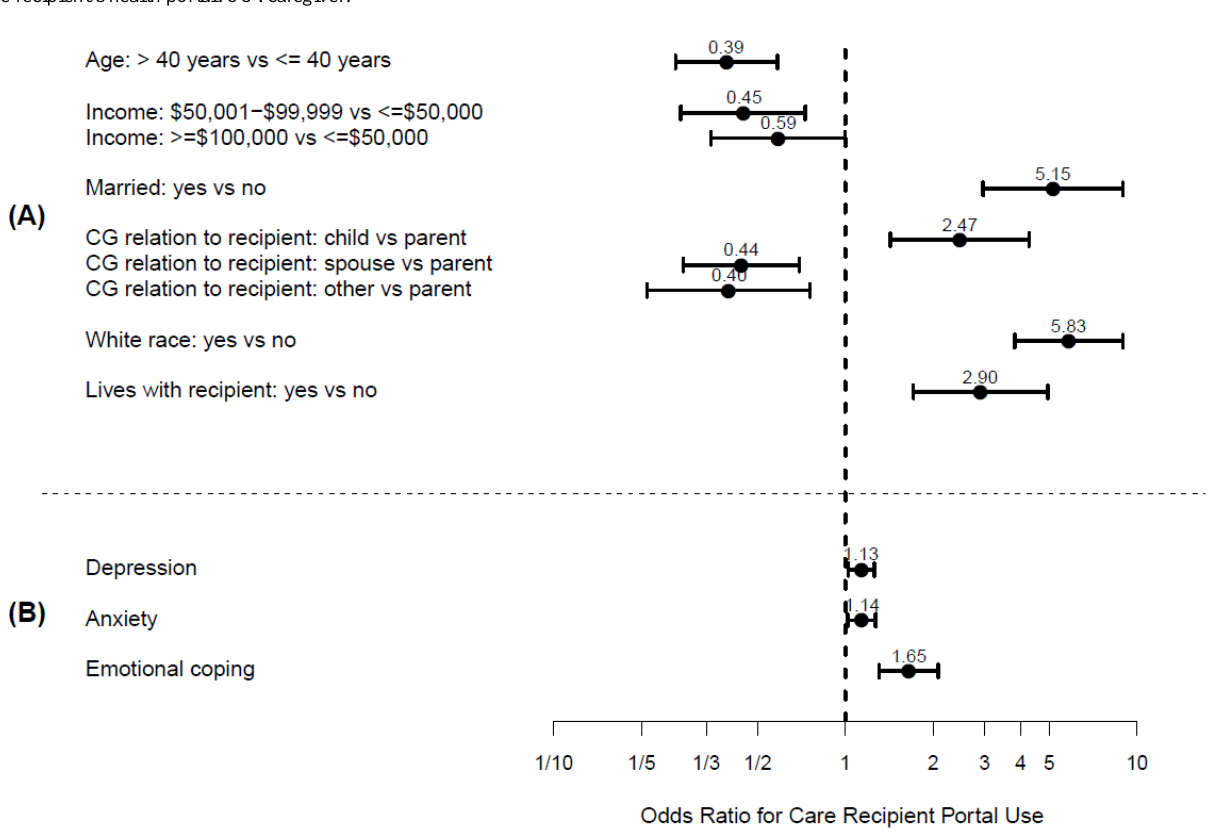
Figure 3. Multivariate odds ratios (dots) and 95% confidence intervals (bars) for (A) caregiver characteristics and (B) mental health for the use of a care recipient’s health portal. CG: caregiver.